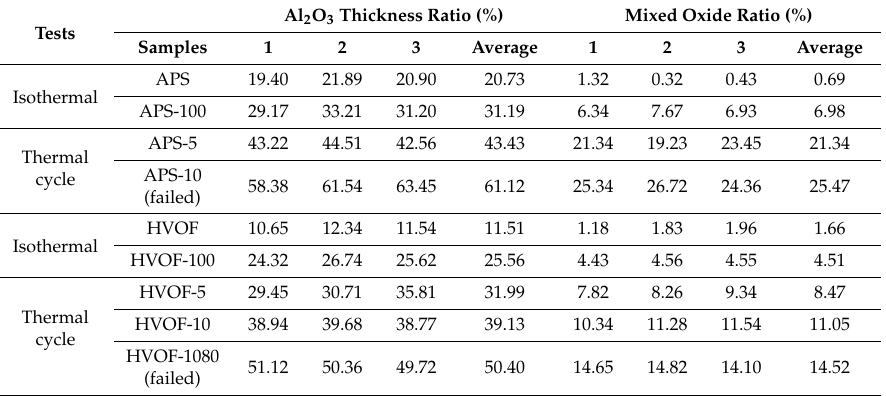
Figure 4. Mixed oxide ratio of APS-bondcoat and HVOF-bondcoat. Table 3. Mixed oxides ratio of APS-bondcoat and HVOF-bondcoat.